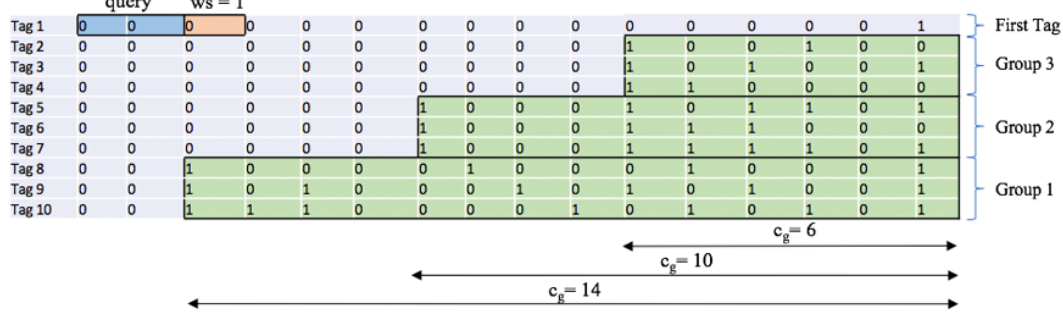
Figure 8. An example of the procedure of the estimation of the tag ID distribution.